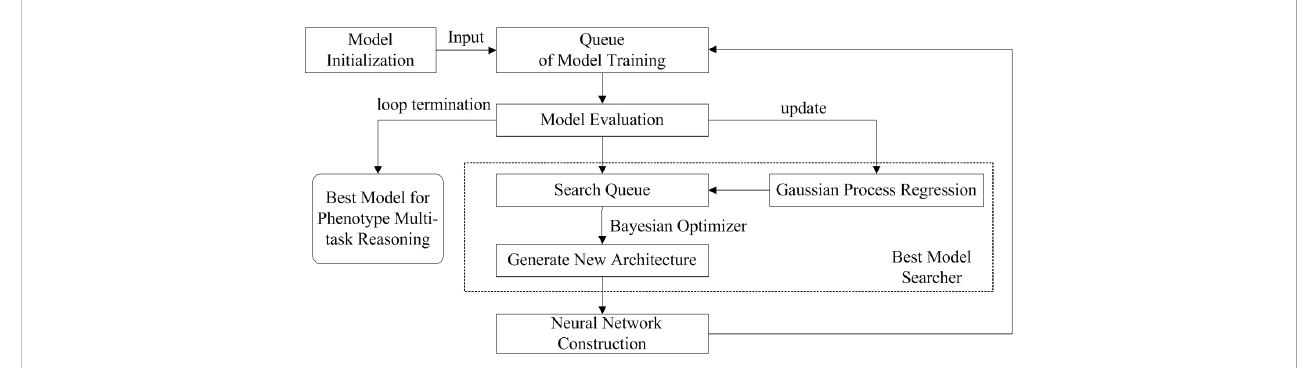
FIGURE 4 The parameters tuning and network structure selection process for Arabidopsis thaliana multi- task phenotype reasoning based on Auto-Keras.